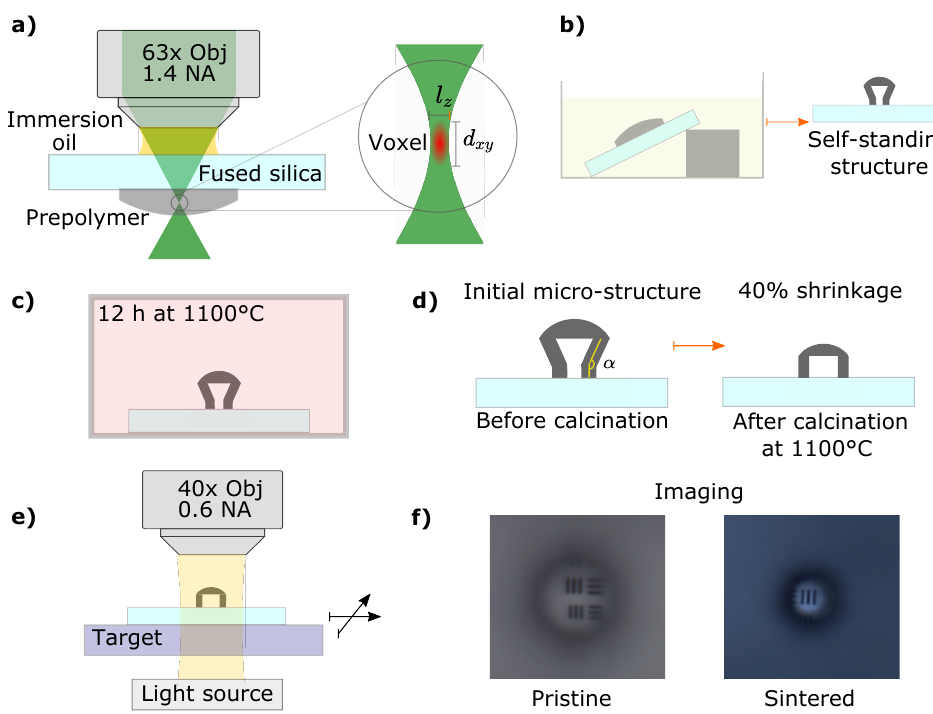
Figure 1. Schematics of the proposed approach: ( a ) LDW process; ( b ) wet chemical development bath (placing the sample with an angle results in a cleaner development process reducing the polymer waste); ( c ) calcination process; ( d ) a geometrical comparison of micro-optical structure prior and post calcination, a pre-compensation angle of the legs is shown as well as an expected shrinkage; ( e ) optical performance characterization of the micro-structure prior and post calcination; ( f ) imaging and measuring the resolving power by a calibration test